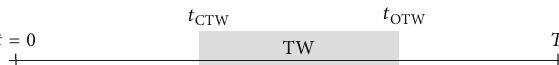
Figure 2: Representation of an access time window policy along the time axis ( 𝑡 = 0 and 𝑇 correspond to the start and end of the day, and 𝑡 CTW and 𝑡 OTW to the closing and opening times of the access time window, resp.).